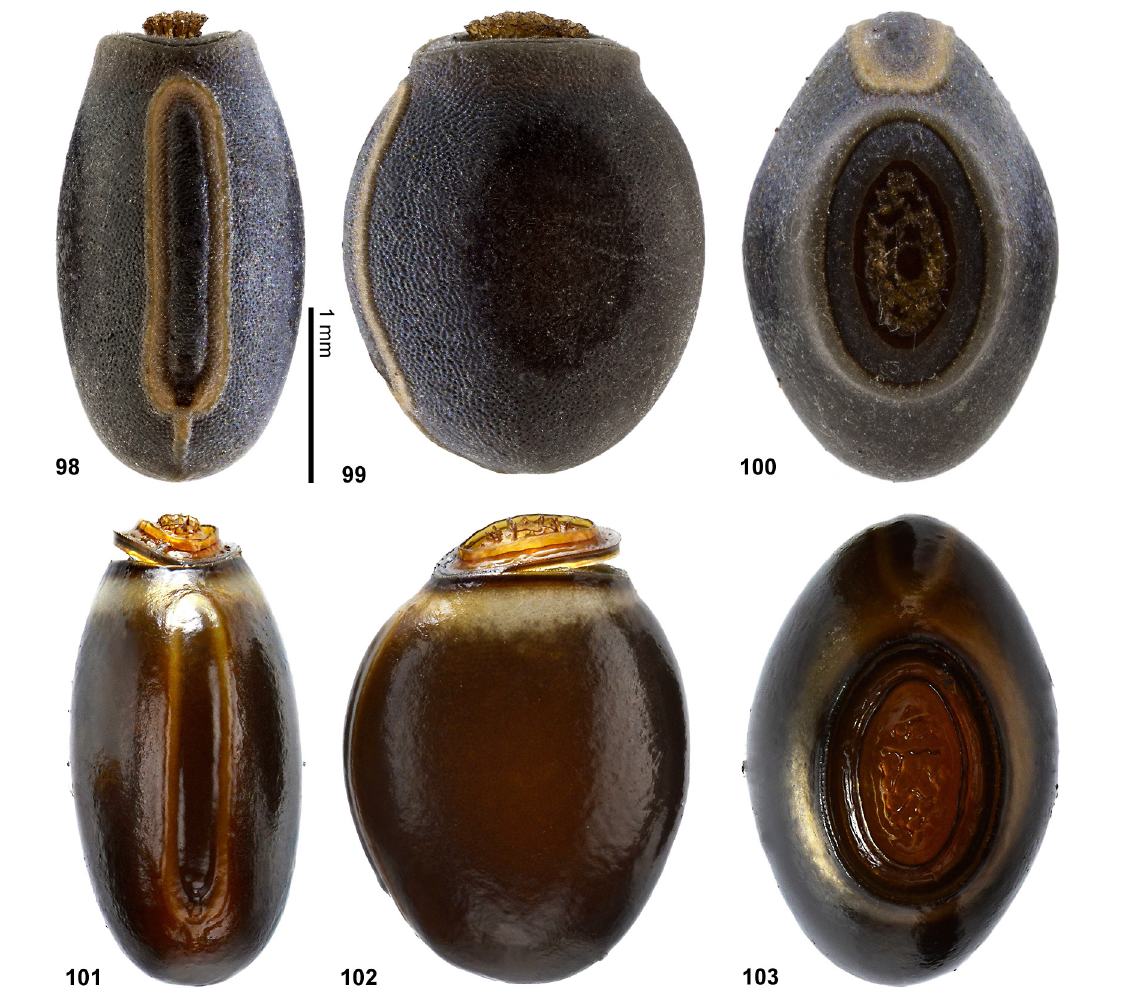
lateral view. 100 . Type B, anterior view. 101 . Type A, dorsal view. 102 . Type A, lateral view. 103 . Type A, anterior